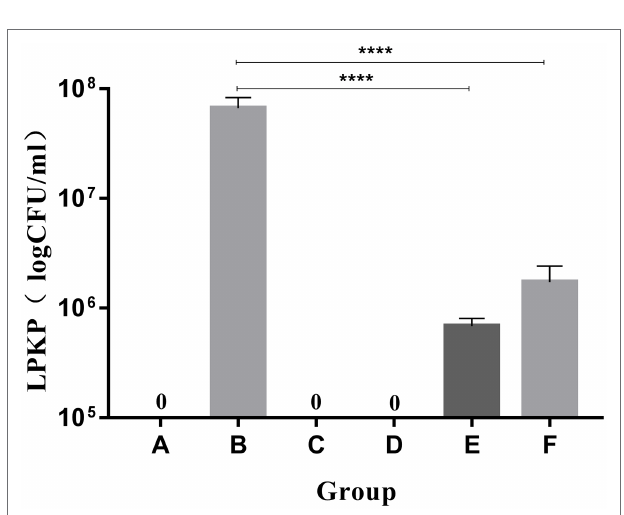
TABLE 5 | Grading of histopathological features in the lungs of mice. Group